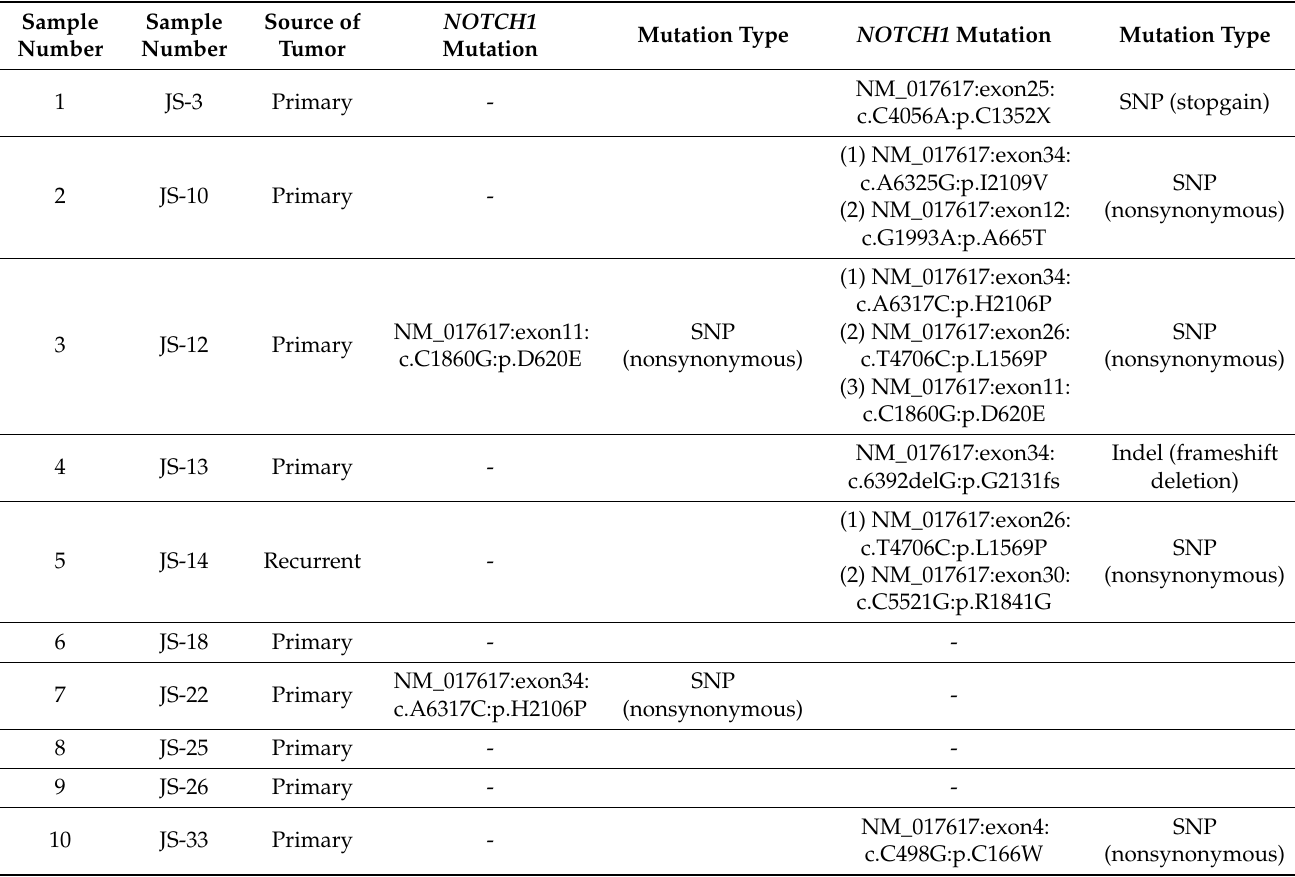
Table 1. The characteristics and mutation information of the 10 paired ovarian cancer